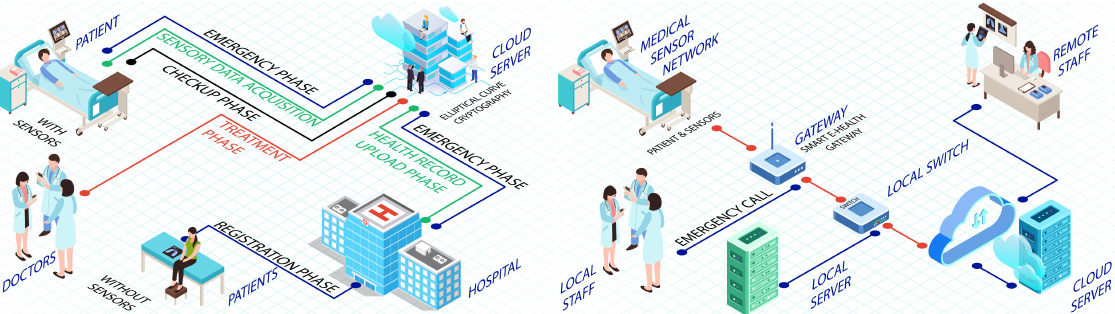
Figure 5. CSEF: Cloud-based secure and efficient framework [90] and An end-to-end security architecture for healthcare IoT